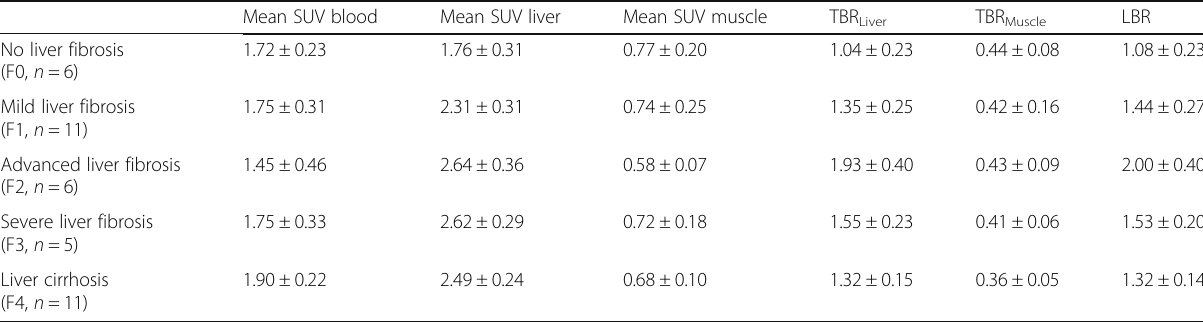
Table 2 This table shows the mean standardized uptake values (SUV) of the liver parenchyma, aortic blood pool, and skeletal muscle with their corresponding tissue-to-blood ratios (TBR), as well as the time corrected liver-to-blood-ratio (LBR) for patients with normal liver parenchyma and patients with different stages of liver fibrosis according to the METAVIR classification